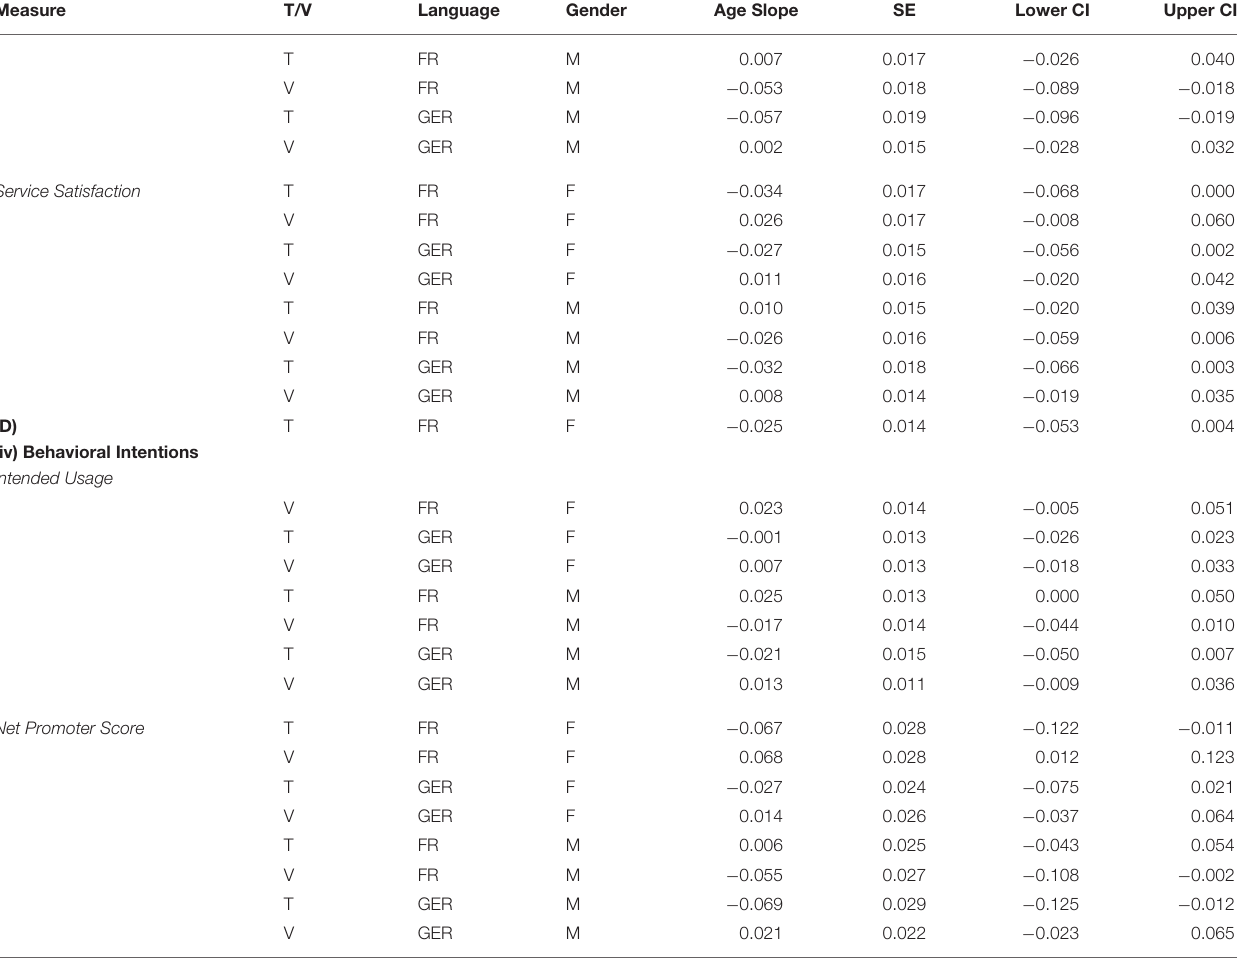
TABLE 6 | Tukey HSD pairwise